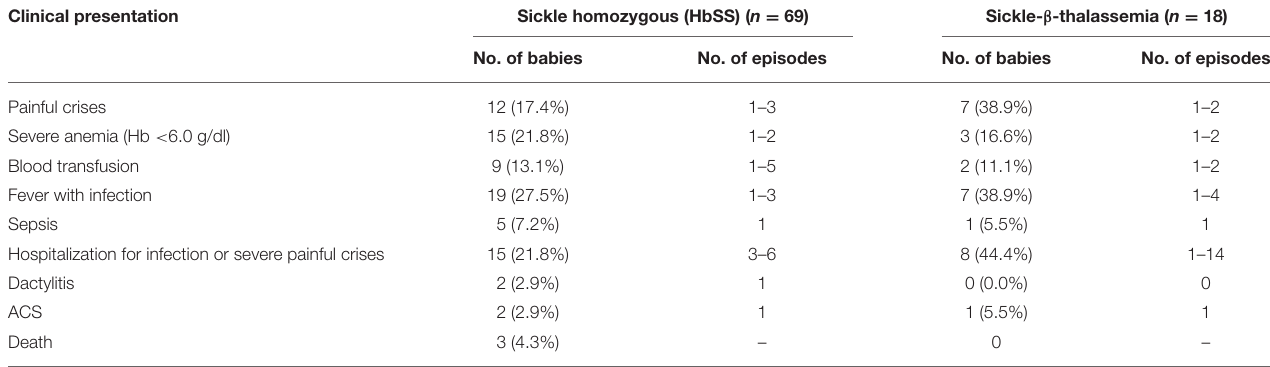
TABLE 3 | Clinical presentation of the babies with sickle cell disease during the follow up period (0.5–6.6 years). Clinical